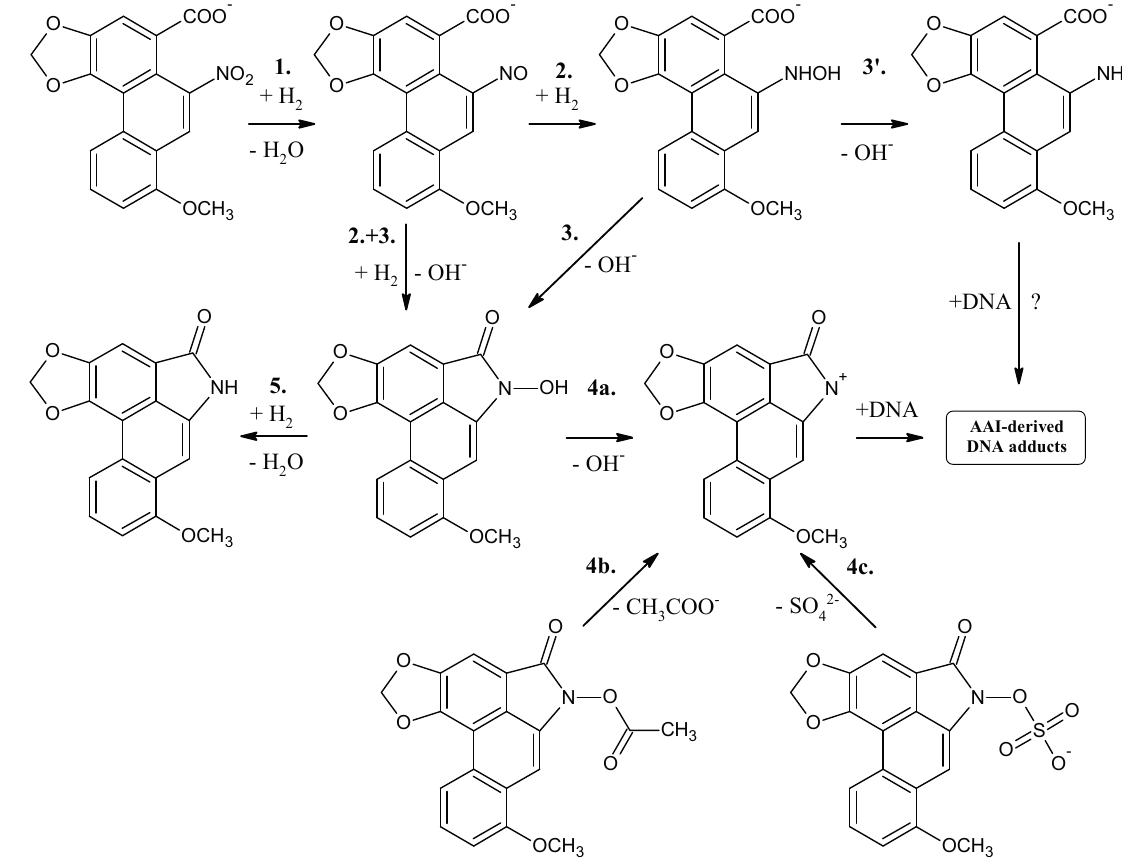
Figure 3. Proposed scheme of reaction steps for aristolochic acid I